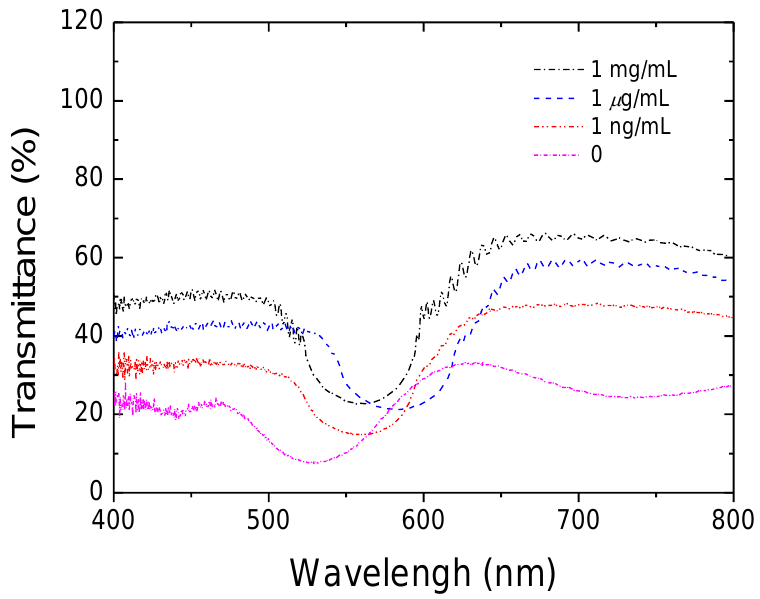
Figure 3. Spectra of the cholesteric liquid crystal (CLC) biological sensor immobilized with various concentrations of heme oxygenase (HO)-1 (0~1 mg/mL).